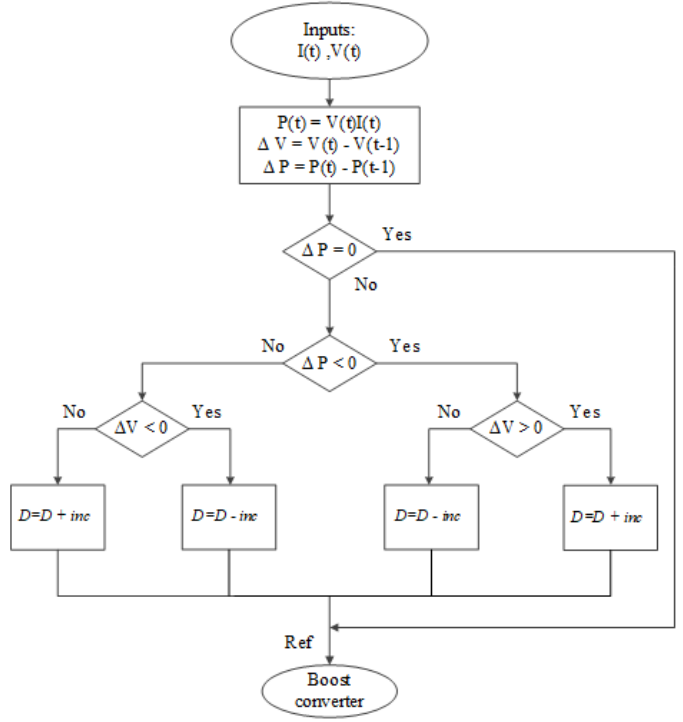
Figure 4. MPPT − P&O algorithm flowchart.